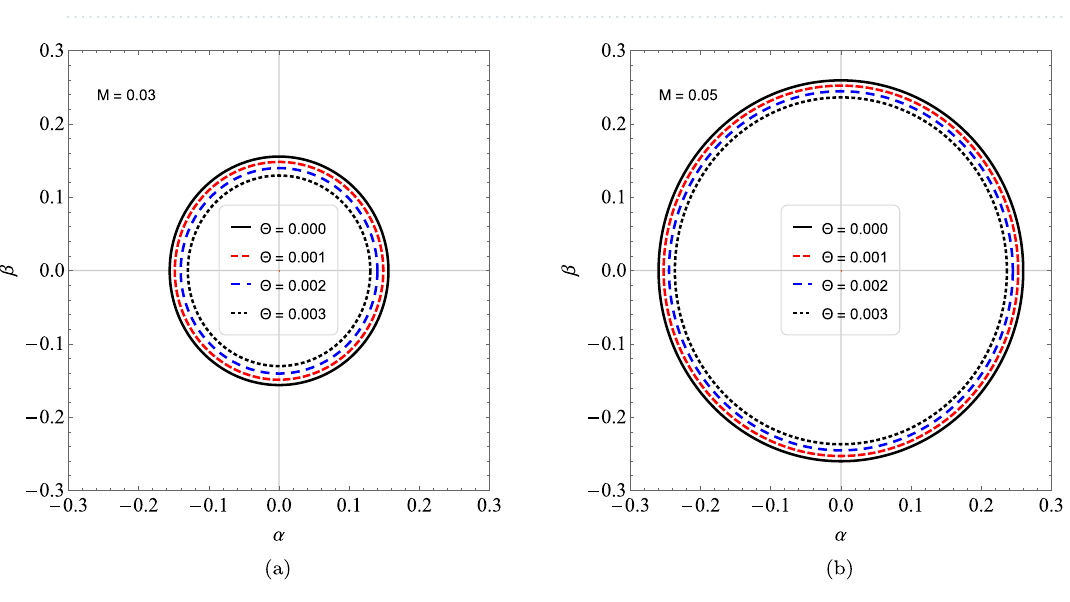
0.1, 0.09, 0.08, 0.06, 0.04 . =